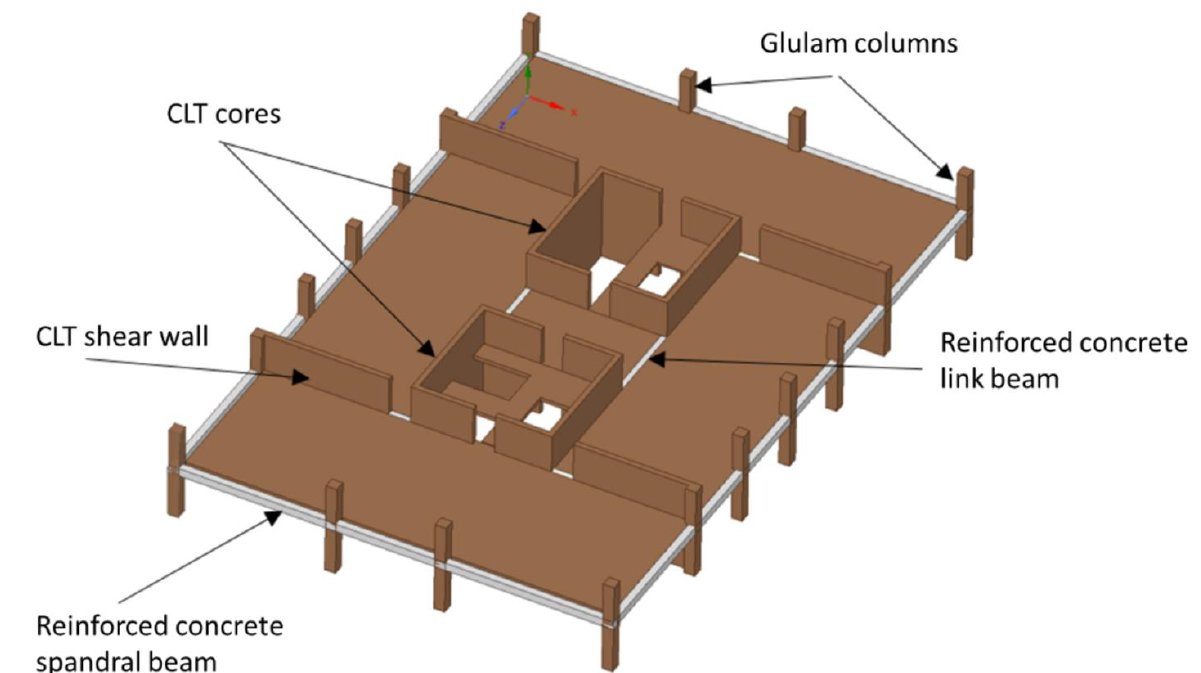
Figure 2. 3D schematic view of a typical floor.